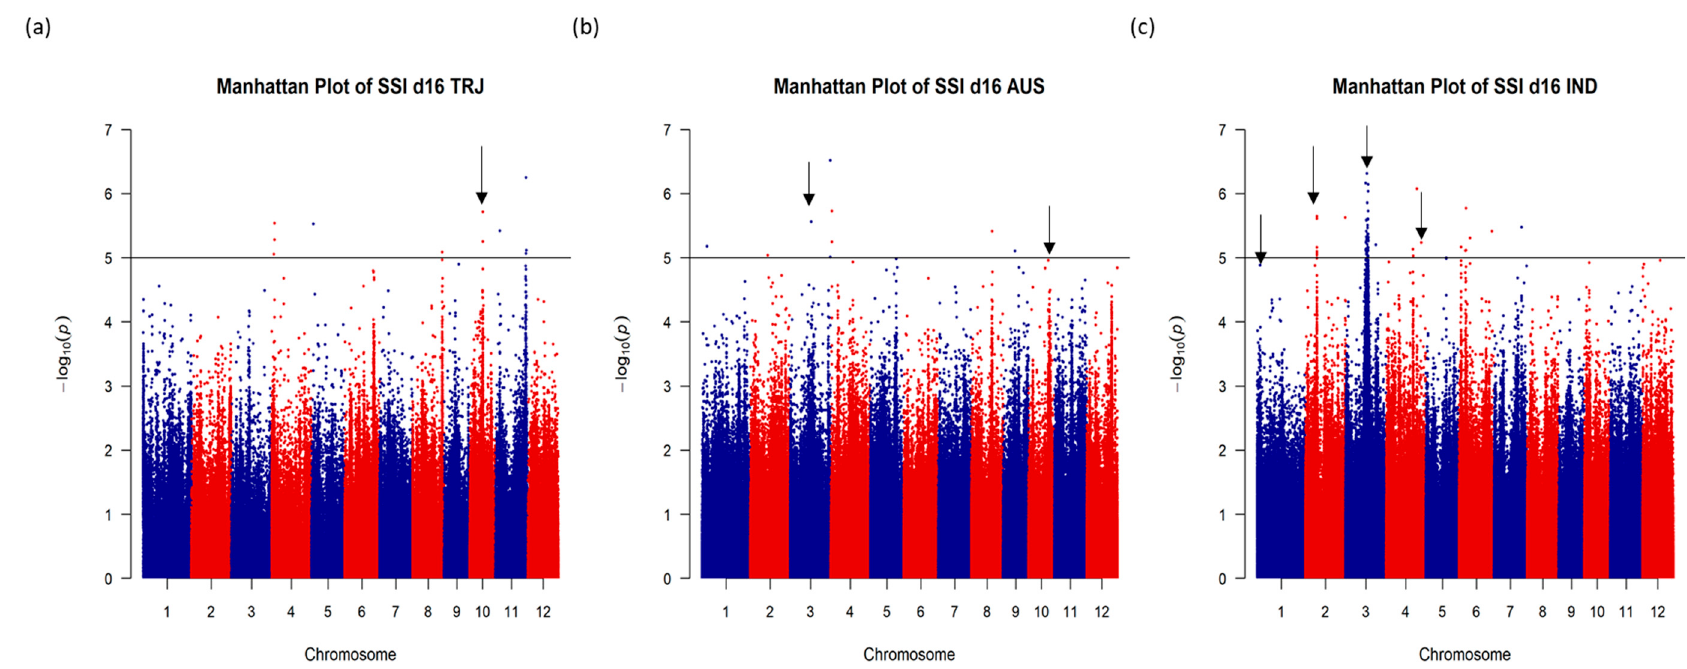
Figure 2. Genome-wide association analysis for salt stress injury score (SSI) on day 16 of salt stress treatment using single-nucleotide polymorphisms (SNPs) from the USDA rice mini-core. Manhattan plots are shown for three rice subpopulations: ( a ) Tropical japonica (TRJ), ( b ) Aus (AUS), and ( c ) Indica (IND). The SNP positions are shown across the 12 rice chromosomes (X axis) with a − log10 (p) value for each SNP (Y axis). The horizontal black line at − log10(p) = 5 is the significance threshold used in the analysis. Black arrows indicate approximate regions for the representative significant SNPs.